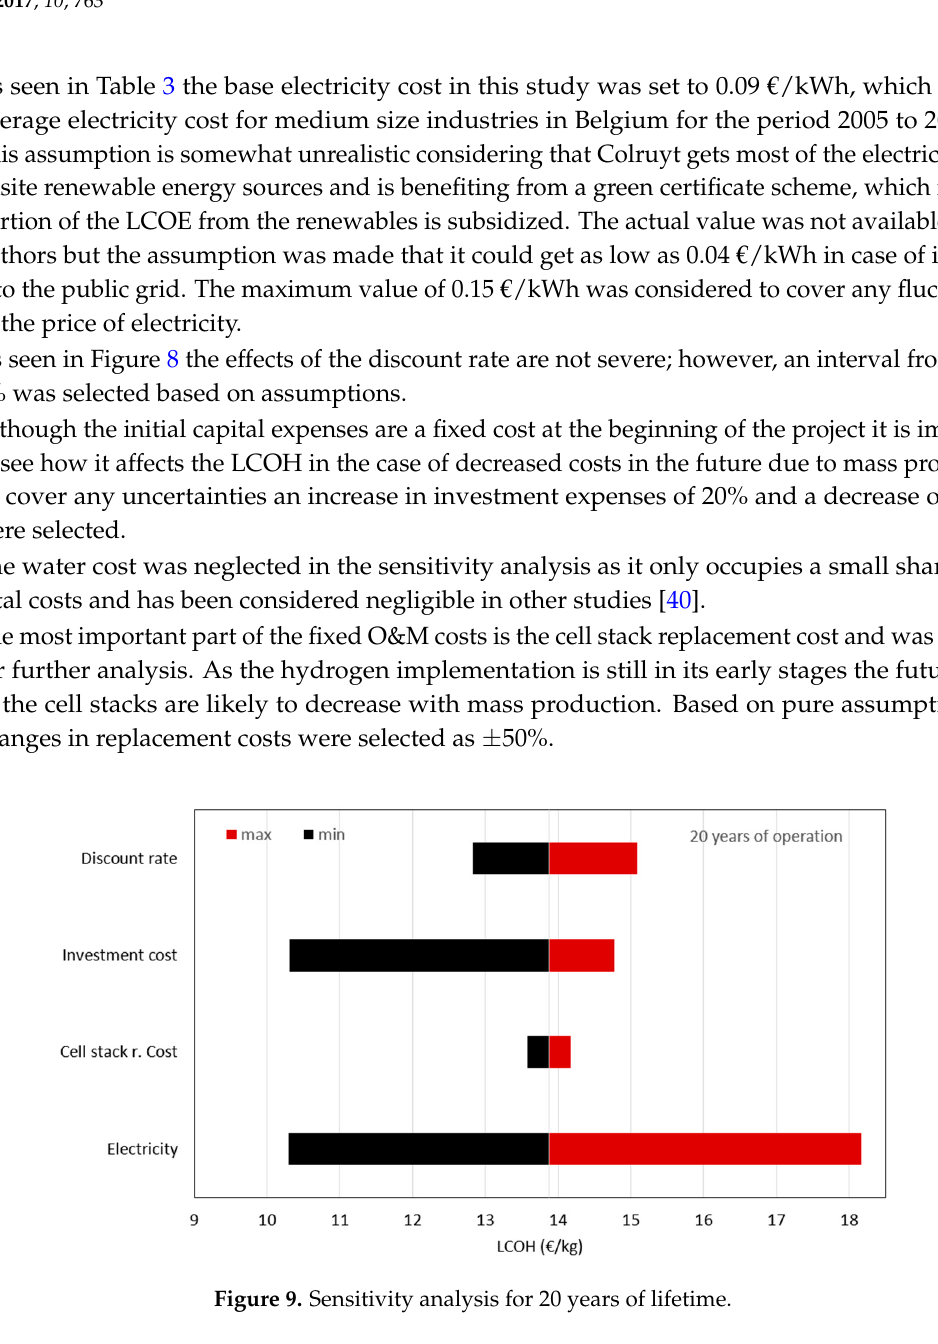
Figure 10. Effects on the LCOH with different operating hours. As Figure 10 indicates the LCOH could reach approximately 18 €/kg if the operating hours are 4380 h (50%) and as low as approximately 12 €/kg at 8322 h (95%), making the operating hours as important factors as the electricity and investment costs. 5. Discussion The main goal of this study was to evaluate the LCOH for a decentralized HRS in Belgium. The cost model was derived from mature and state of the art literature and the calculations were based on a comprehensive field data collection to ascertain as realistic costs as possible. The results can also be used as benchmarks for the next phase of the DQ project, where a new state of the art PEM WE and FC have been added to the current HRS.